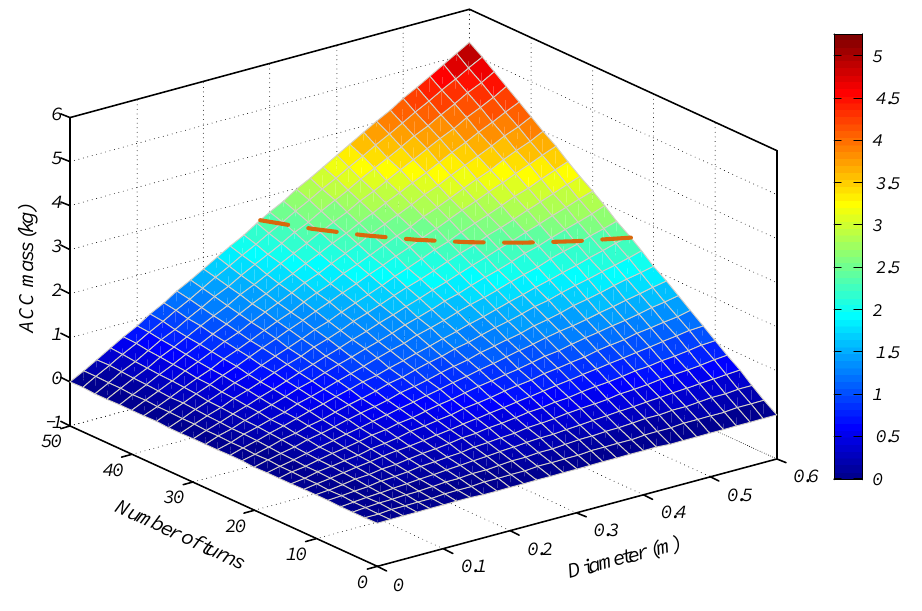
Figure 4. Contour map of the air-core coil mass M versus its n and